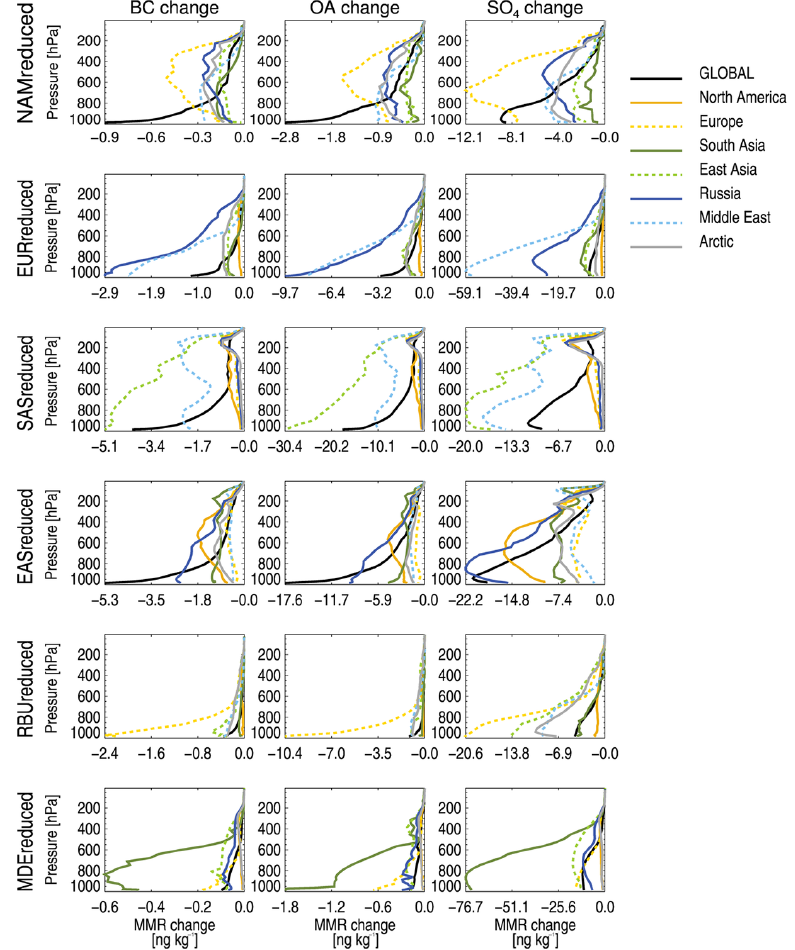
Figure 5. Model-averaged aerosol MMR change profiles for different receptor regions (marked by the colors of the lines), for emission reductions in the six source regions (rows) and for BC (first column), OA (middle column) and SO 4 (last